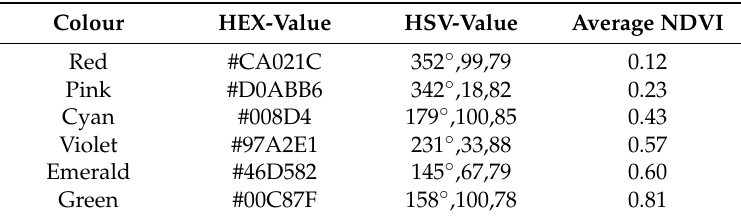
Table 2. Colour panel information including